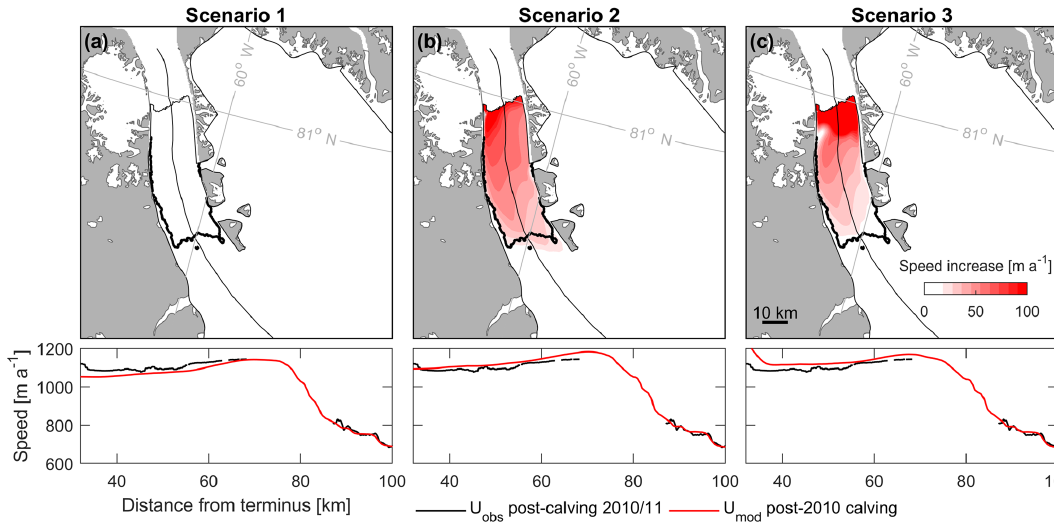
Figure 5. Diagnostic perturbation experiments for the 2010 calving event, using three scenarios of boundary conditions applied along the floating ice tongue (a–c) . Graduated white to red shows speed increase between initial modeled velocities ( U initial ) and modeled velocities after the 2010 calving ( U calving ). Bottom plots show observed velocities ( U obs ) after calving (winter 2010/2011) and modeled velocities ( U mod ) after the 2010 calving along the glacier